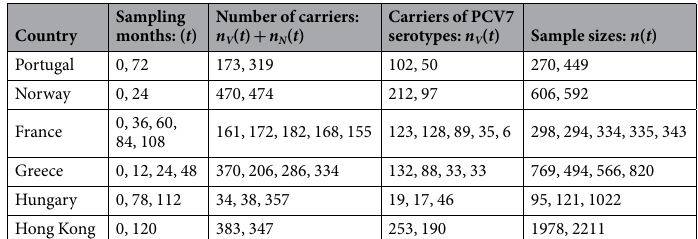
Sampling Number of carriers: Country months: ( t ) n V ( t ) + n N ( t )